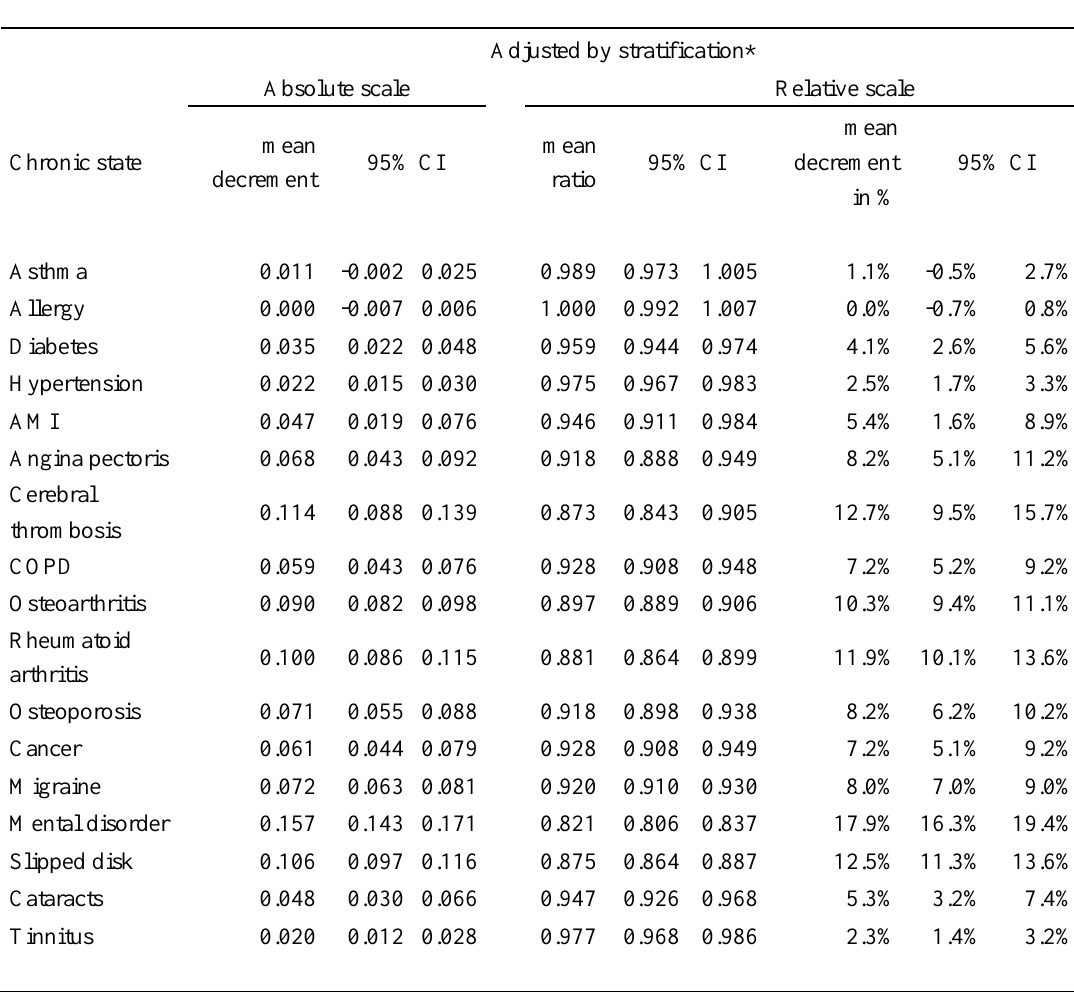
Table 3: Estimated decrements in mean EQ-5D-3L index score on both absolute and relative scale adjusted for sex, age and the number of co-morbid chronic conditions Adjusted by stratification* Absolute scale Relative